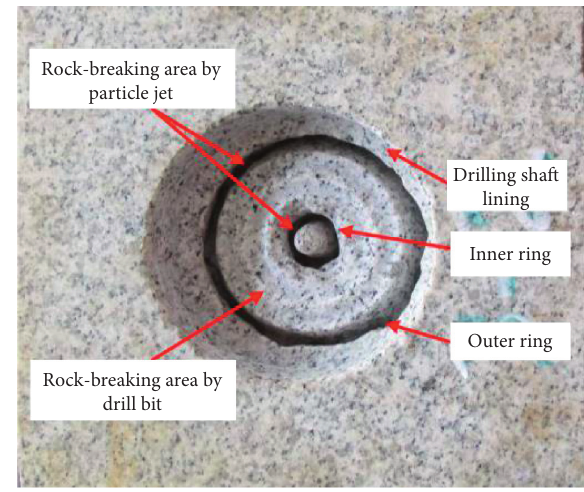
Figure 14: Analysis of rock-breaking sample.